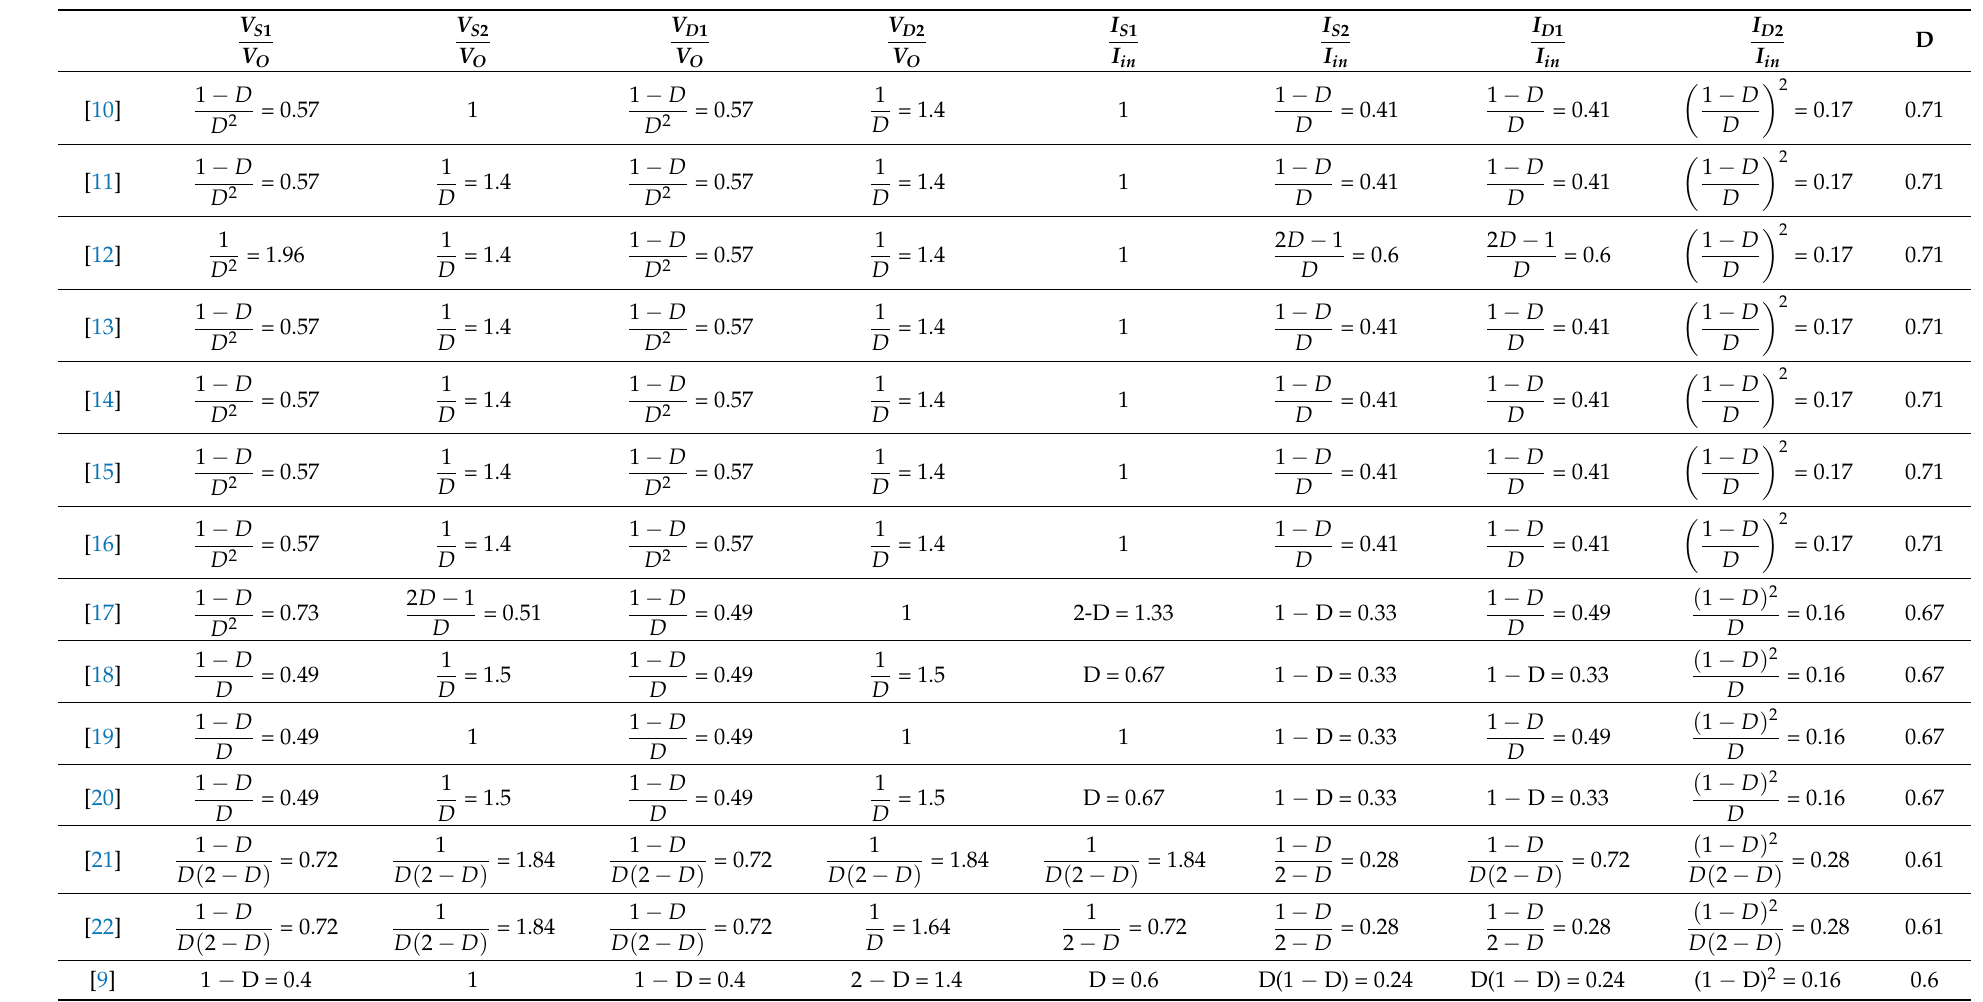
Table A1. Comparison of the voltage/current